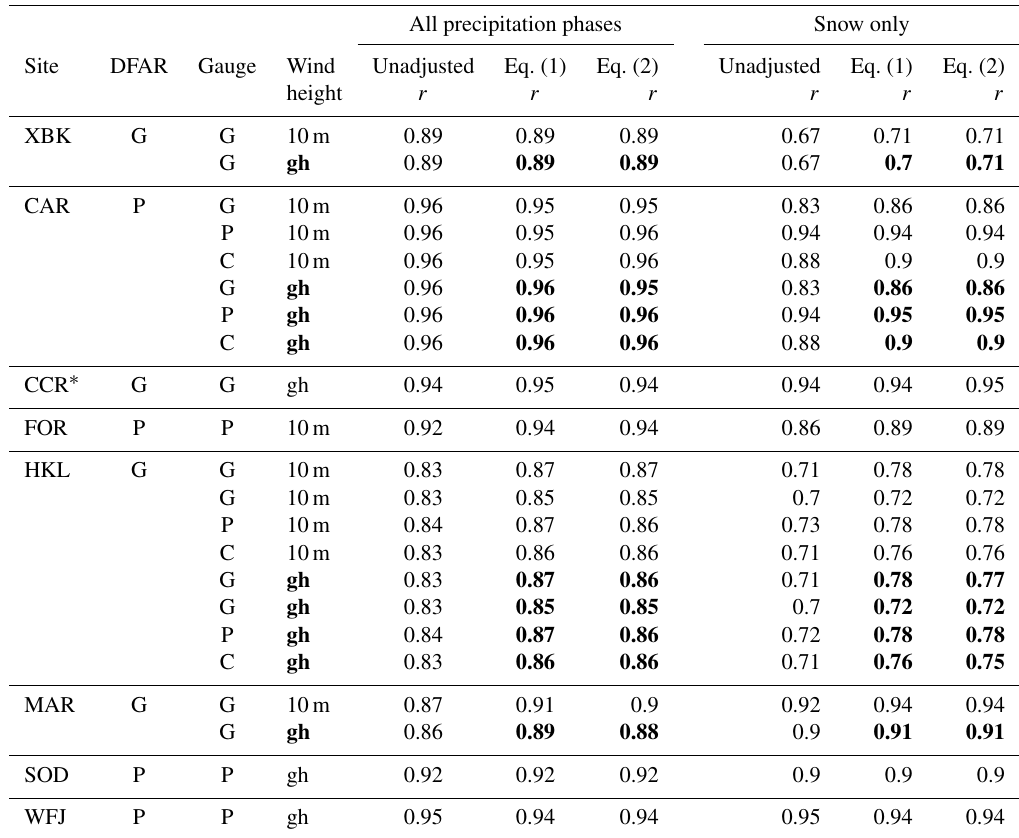
Table 6. Pearson correlation ( r ) for the single Alter-shielded gauges (G – Geonor; P – Pluvio 2 ) as compared to the DFAR reference at each site for the combined winters of 2015/2016 and 2016/2017 for available wind speed measurement heights (10m; gh – gauge height) and for Eqs. (1) and (2). Metrics are separated by precipitation phase (all and snow only). Where both wind speed heights are available, the gauge height data are shown in